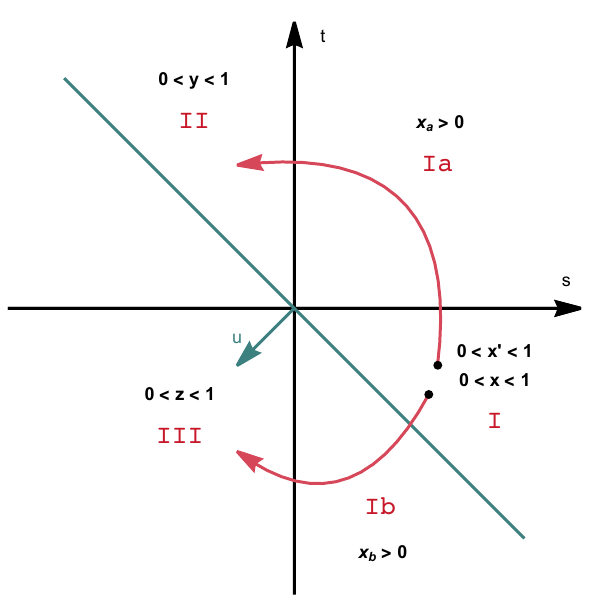
Figure 5 . Paths in phase space to obtain the crossed